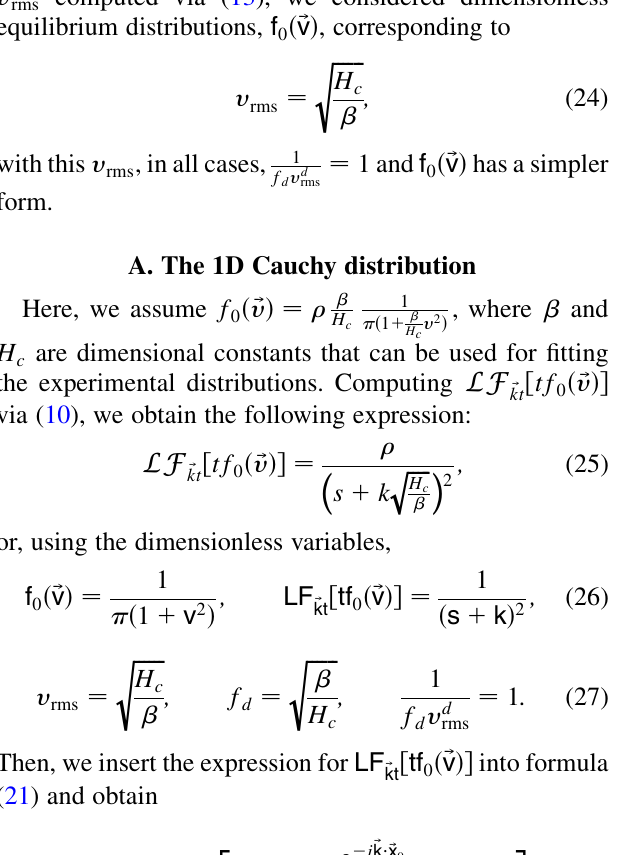
FIG. 1. The exact values and the ones obtained numerically via the FFT for the 1D Cauchy distribution, for the various velocities of the external charge. Solid lines represent the exact values and the FFT values are shown by marks of different shapes regarding the